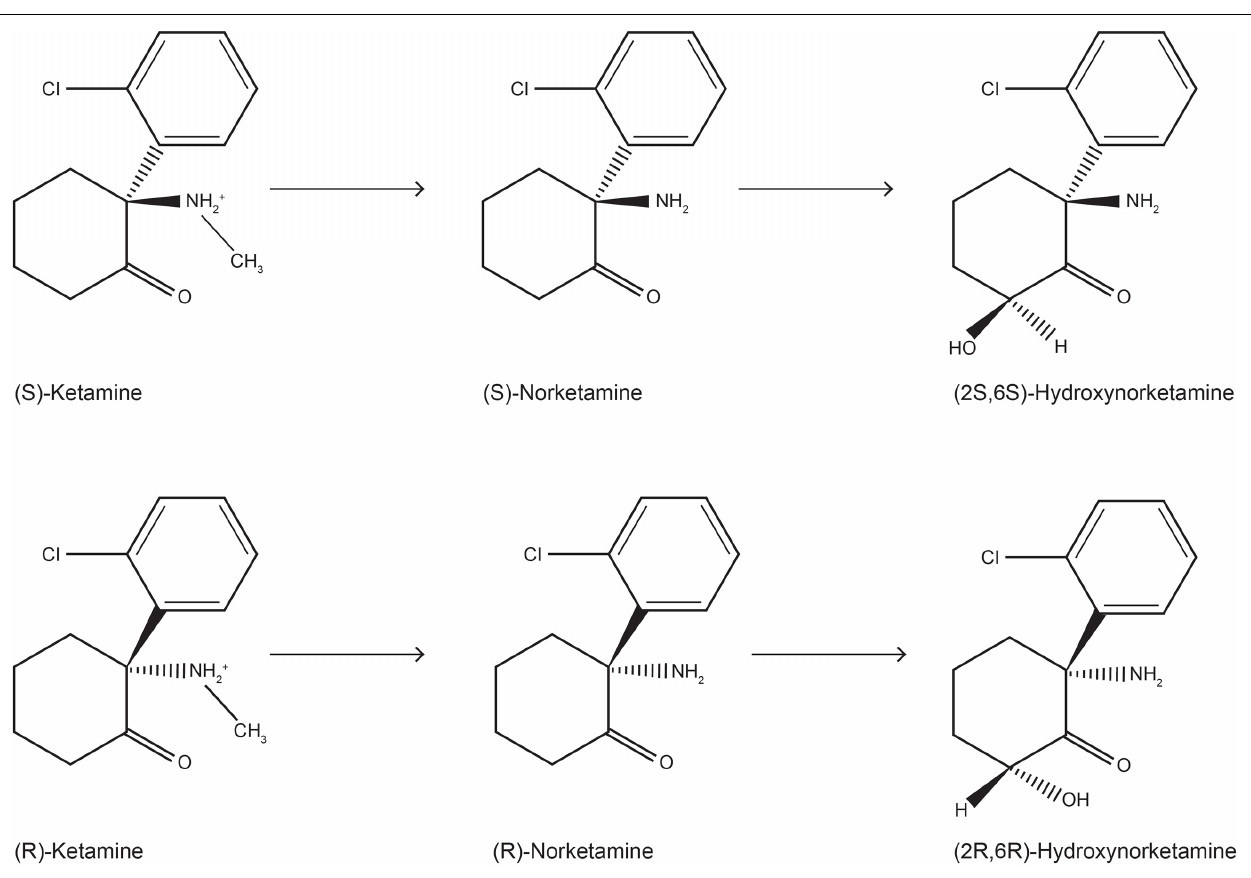
FIGURE 1 | Chemical structure of ketamine stereoisomers and metabolites that can be formed following ketamine infusion in